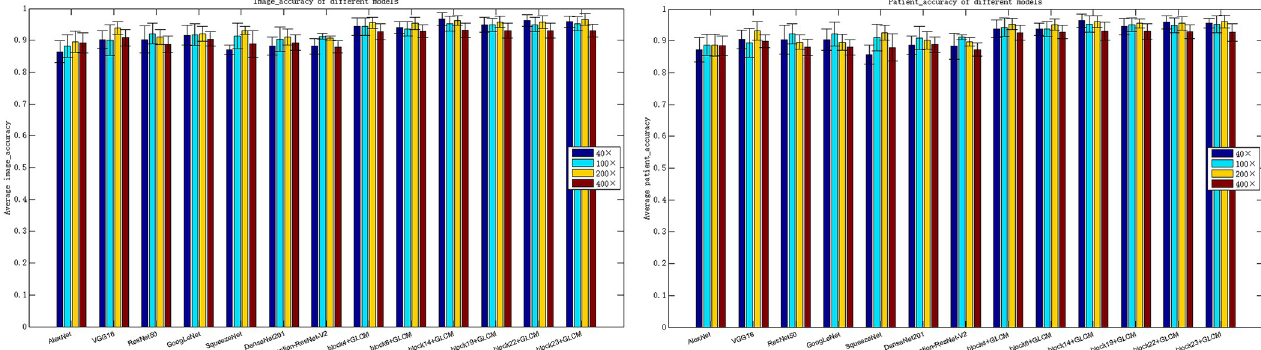
Fig 7. Comparison of the baseline models with the method proposed in this paper. (a) Image-level recognition accuracy, (b) patient-level recognition accuracy.